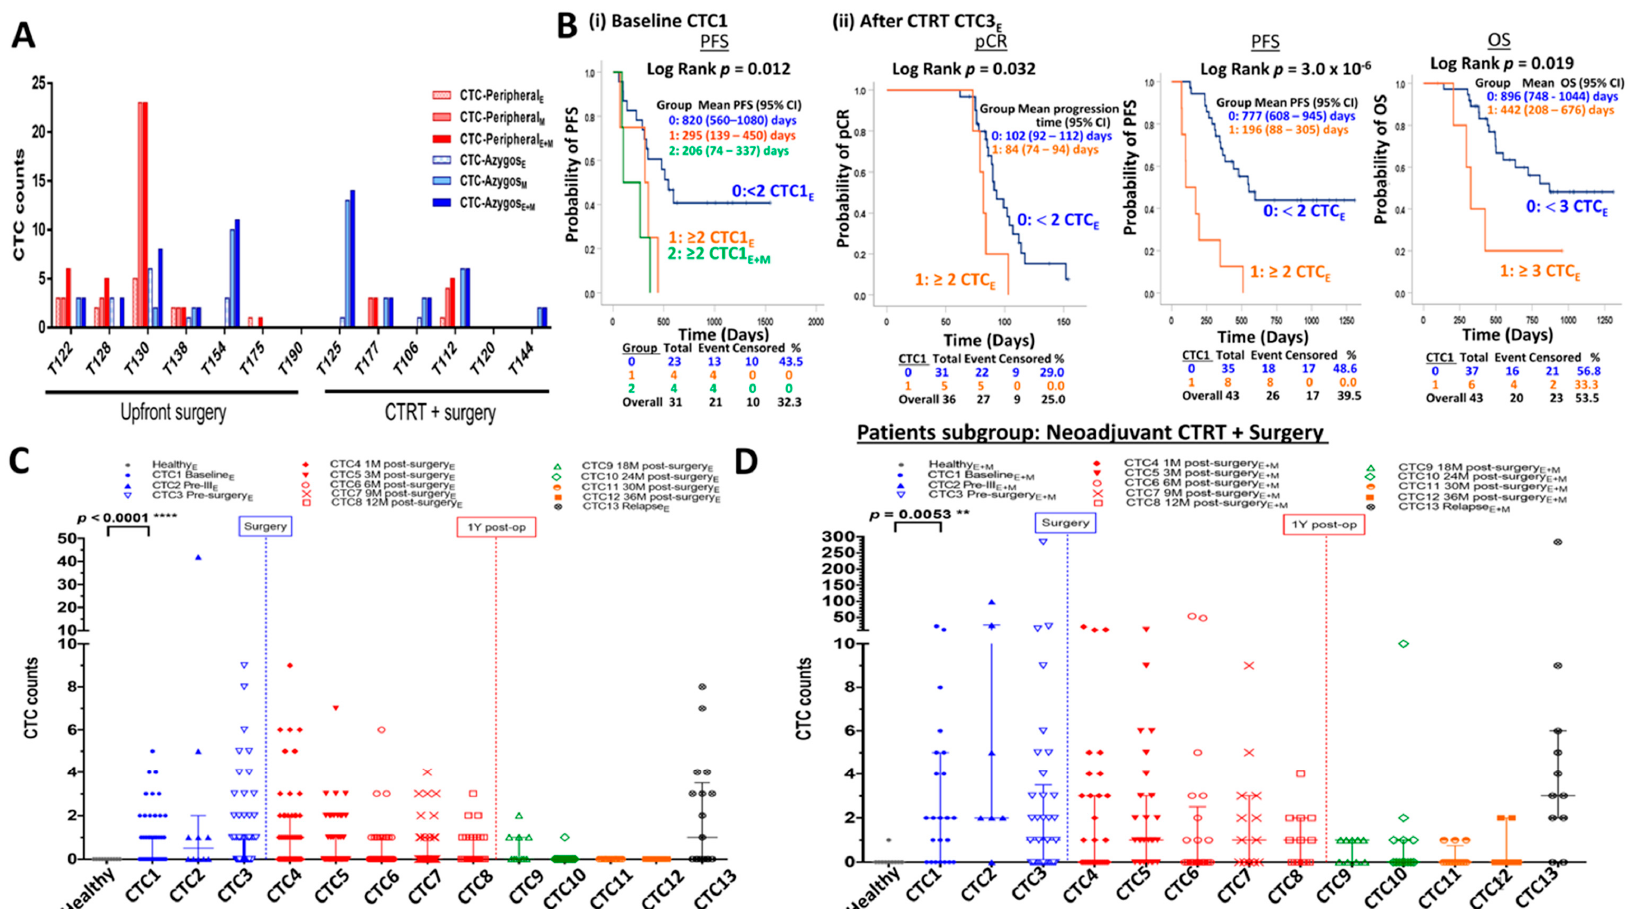
Figure 1. Summary of CTC counts of resectable ESCC. ( A ) Enumeration of the CTC E and CTC E+M from the azygos vein and peripheral bloods on the day before surgery from 13 ESCC patients. ( B ) Kaplan–Meier survival analysis of patients treated by CTRT + surgery of ( i ) CTC1 enumeration at baseline with PFS, and ( ii ) CTC3 E enumeration at the end of CTRT with pathological complete response (pCR), PFS, and OS. Summary of the enumeration of ( C ) of epithelial CTC E (EpCAM/pan- CK/MUC1) and ( D ) total CTC E+M with additional vimentin marker for CTC1–CTC13 in ESCC patients treated by curative treatment and normal individuals. The median with interquartile range (IQR) is indicated by error bar. Details of CTC1-CTC13 refer to Supplementary Figure S2. ** p -value < 0.01, **** p -value <